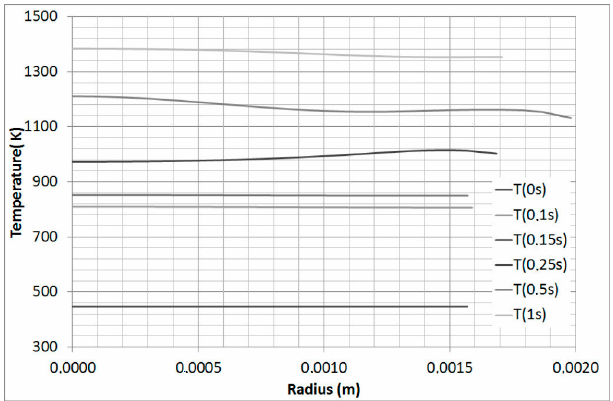
Figure 10. Interface temperature distribution with time along- r radial distance